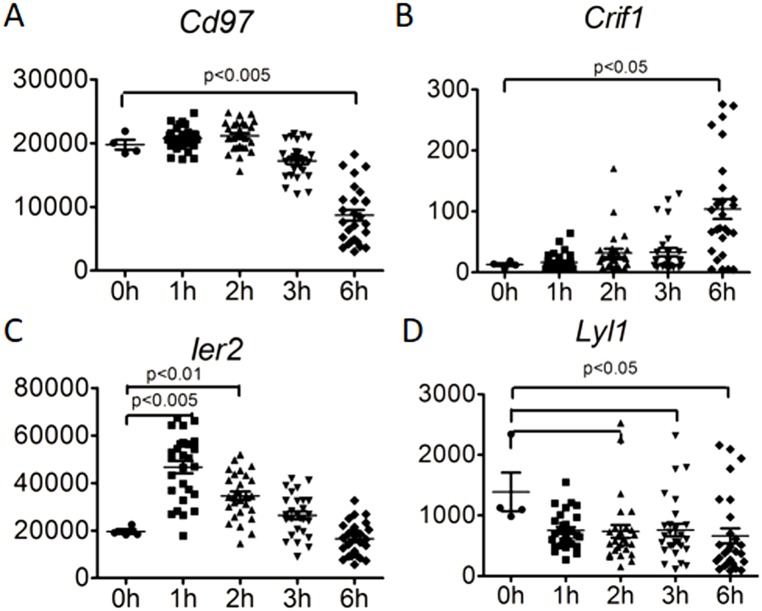
Expression of candidate genes in human neutrophils upon S. aureus infection.Expression of Cd97, Crif1, Ier2 and Lyl1 in S. aureus-challenged human neutrophils were significantly different as compared as naïve status. Human neutrophil data from public data set GEO:GSE16837 (http://www.ncbi.nlm.nih.gov/geo/query/acc.cgi?acc=GSE16837) was analyzed. Cd97 (0.44 fold, p<0.0001) and Lyl1 (0.48 fold, p<0.05) were decreased at 6hr after S. aureus stimulation. By contrast, Crif1 (8.70 fold, p<0.05) and Ier2 (1.77 fold, p<0.05) were significantly increased at 6hr and 2h, respectively, after S. aureus stimulation.